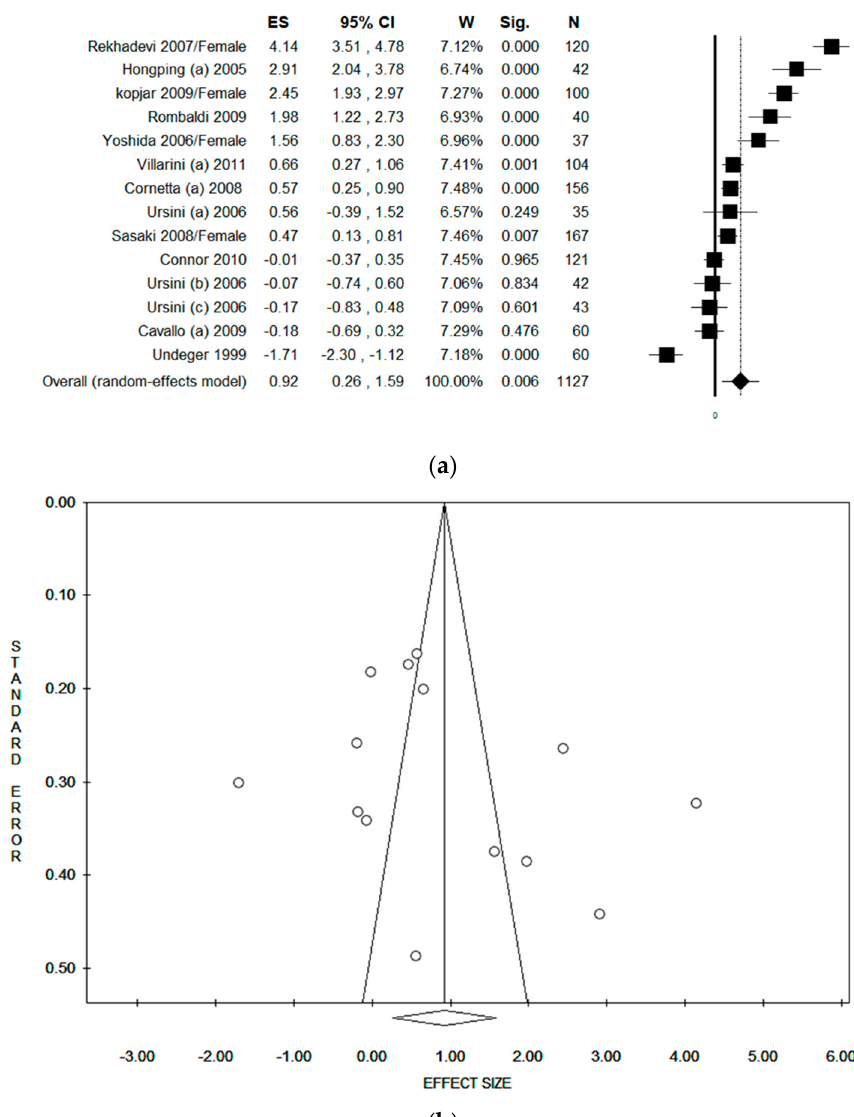
Figure 4. ( a ) Forest plot and ( b ) funnel plot (after trim and fill method) of the meta-analysis